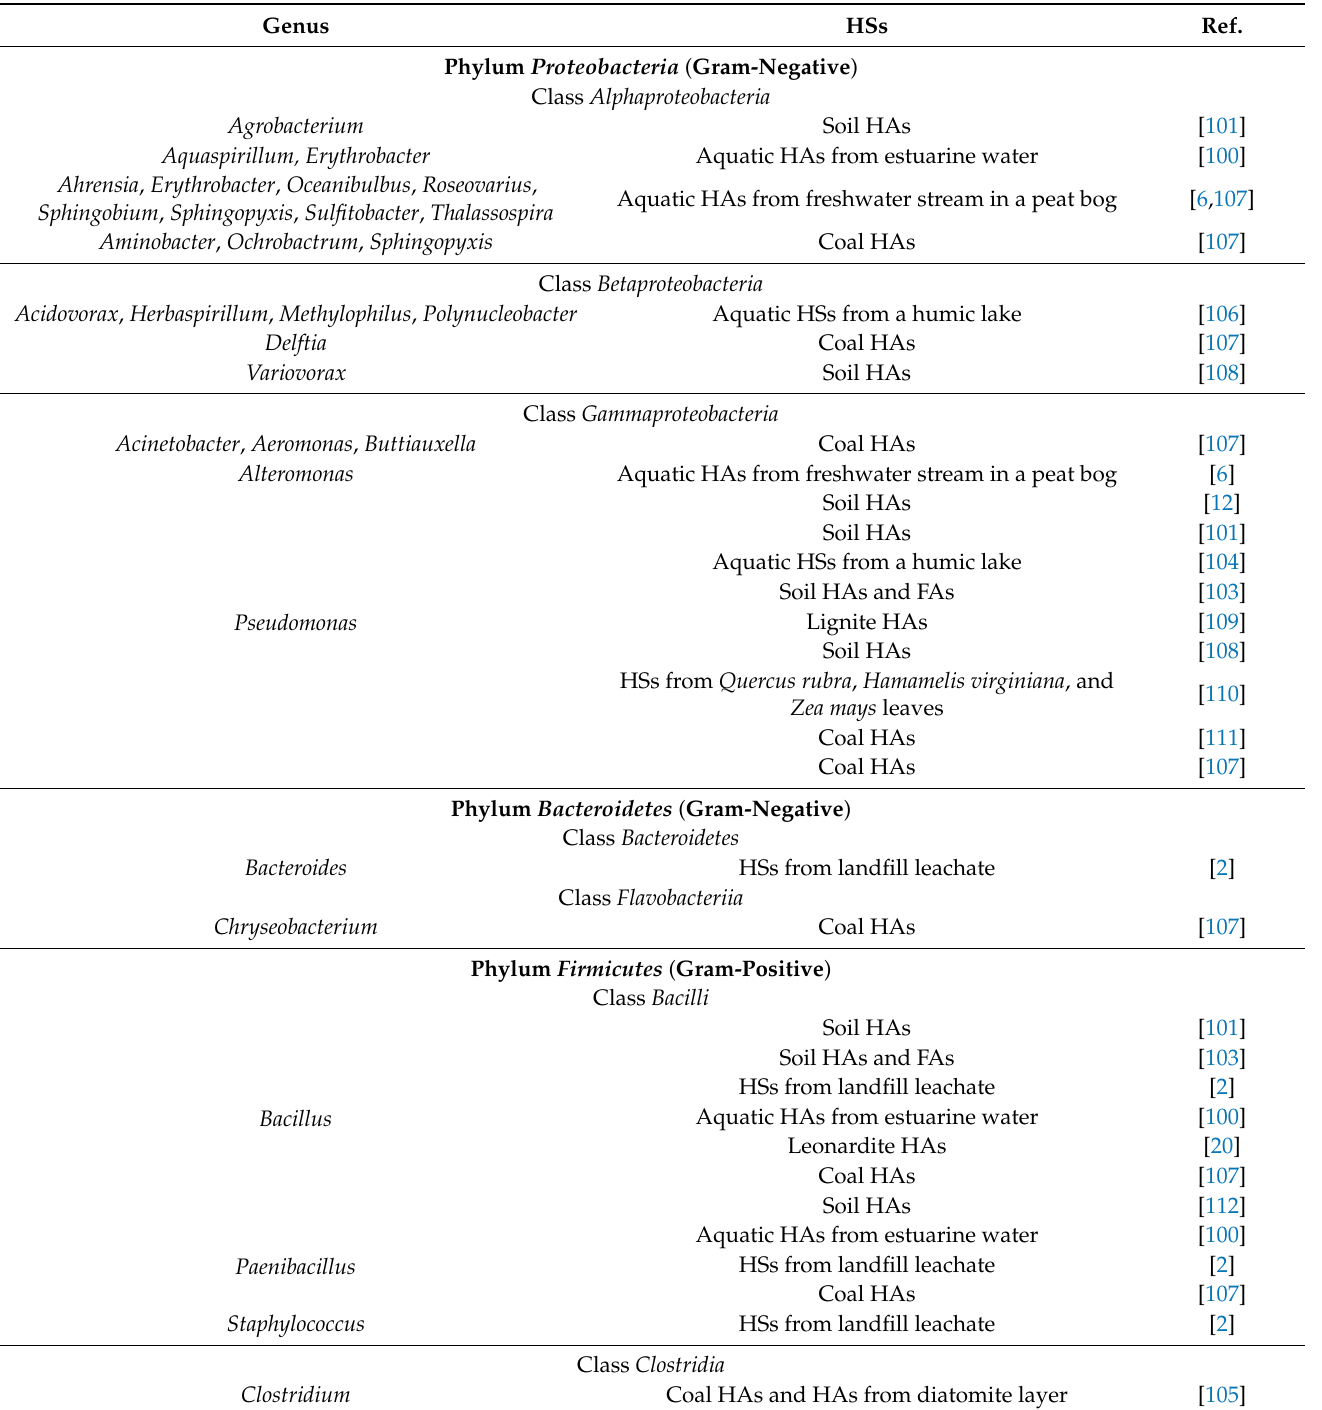
Table 2. Some genera of humic-degrading